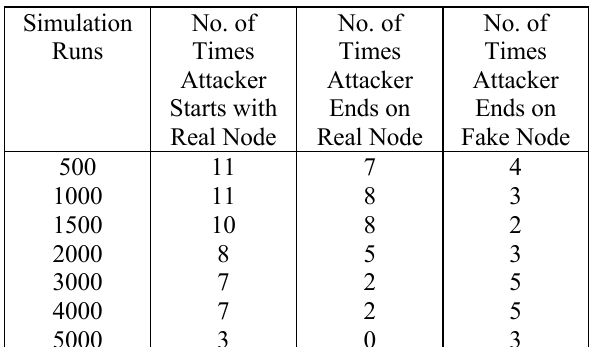
Table 7. Performance evaluation table for real to real and